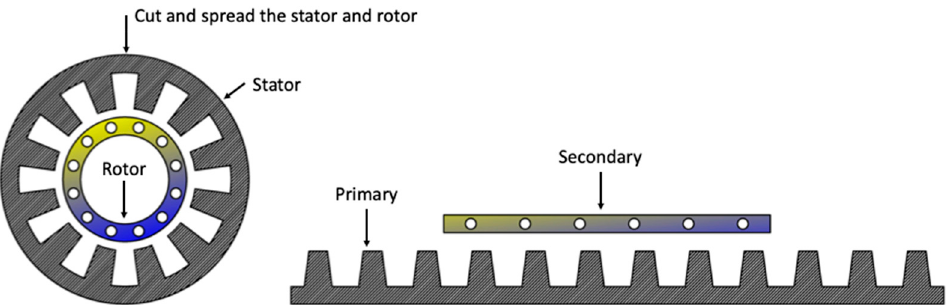
Figure 2. Cutting and unrolling process to obtain an LIM and its various parts.